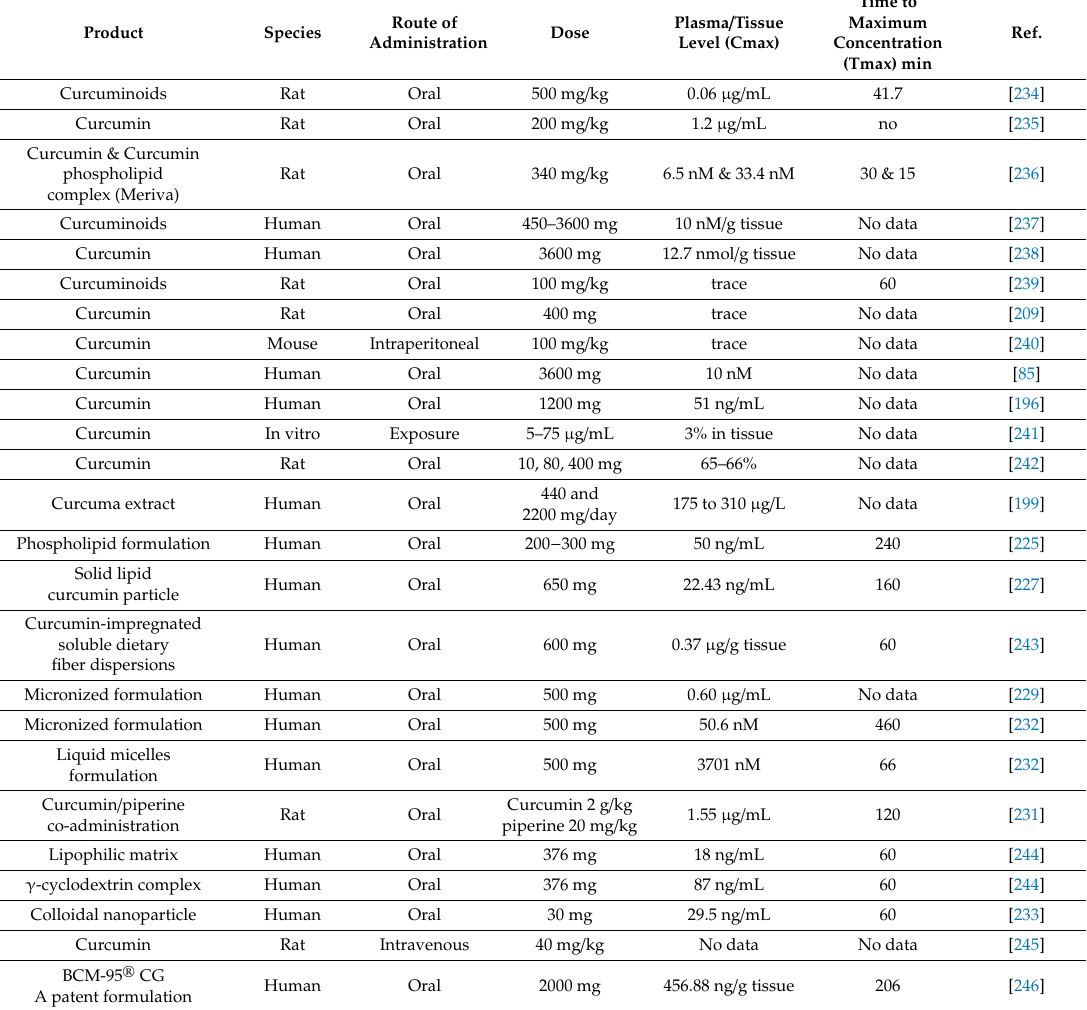
Table 8. Pharmacokinetic characteristics of some curcumin formulations in animal and clinical studies.